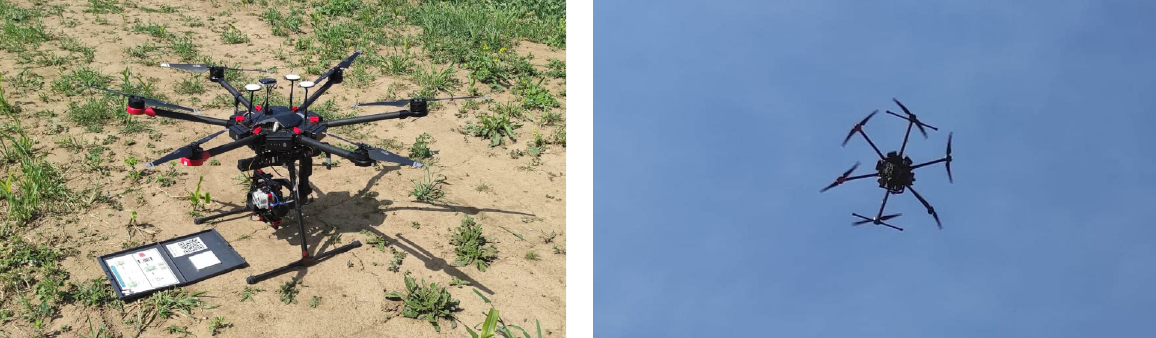
Figure 3. The six-rotor UAV DJI Matrice M600 with Micasense Altum camera on the ground with Figure 3. The six ‐ rotor UAV DJI Matrice M600 with Micasense Altum camera on the ground with calibration panel ( left ) and during the flight ( right ). calibration panel ( left ) and during the flight ( right ).